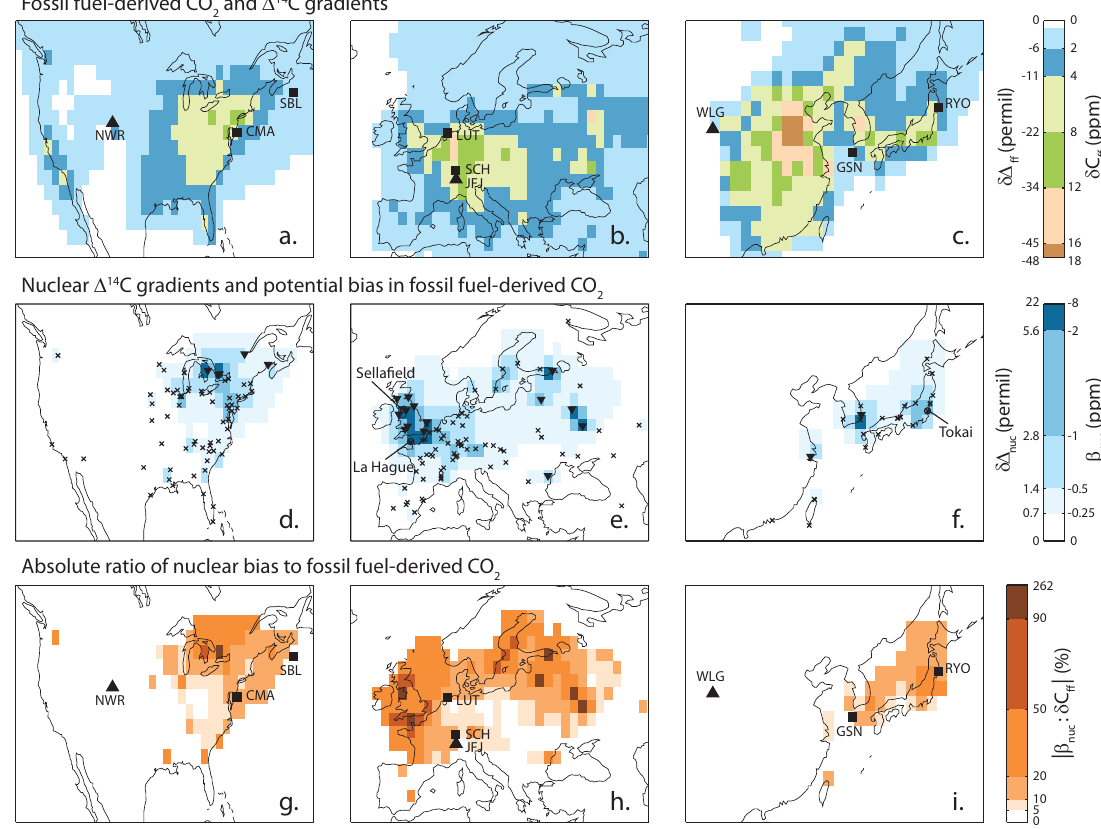
Fig. 2. (a–c) Maps of fossil fuel-derived CO 2 ( δC ff ) and 1 14 C dilution ( δ1 ff ) in continental regions of the Northern Hemisphere. Regional reference sites are indicated by triangles and observation sites by squares. (d–f) Nuclear 1 14 C enhancement ( δ1 nuc ) and potential nuclear bias to fossil fuel-derived CO 2 ( β nuc ). Locations of low- 14 C release reactors are indicated by crosses, high- 14 C release reactors by triangles, and spent fuel reprocessing sites are labeled. (g–i) The ratio | β nuc : δC ff | , in percent, shown only in grid cells where β nuc was less than − 0 .